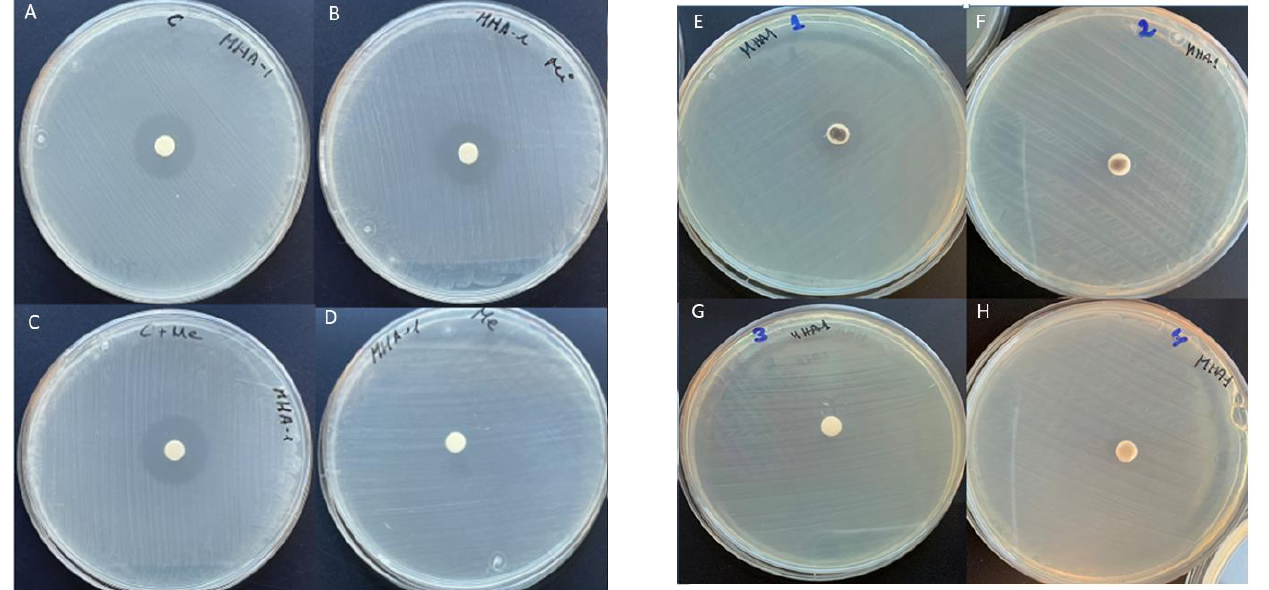
Figure 1. Halos of inhibition against E. faecalis . ( A ) Ciprofloxacin; ( B ) minocycline; ( C ) ciprofloxacin + metronidazole. ( D ) metronidazole; ( E ) SBA-15 + 4:4:28 *, SBA-15 (Santa Barbara Amorphous 15) OMS (Ordered Mesoporous Silica); ( F ) SBA-15 + 2:2:14 *; ( G ) SBA-15; and ( H ) SBA-15 + 1:1:17 *. * (Ci:Me:Mi).